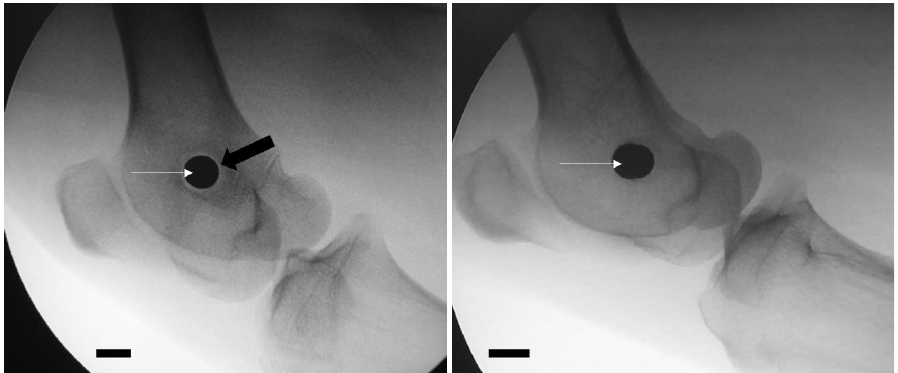
Figure 3. Presence of a radiolucent halo (black arrow) in the periphery of the implant (white arrows) in an animal of osteomyelitis group ( left image), as opposed to the absence of a halo in the control group ( right image). Scale bar = 1 cm.